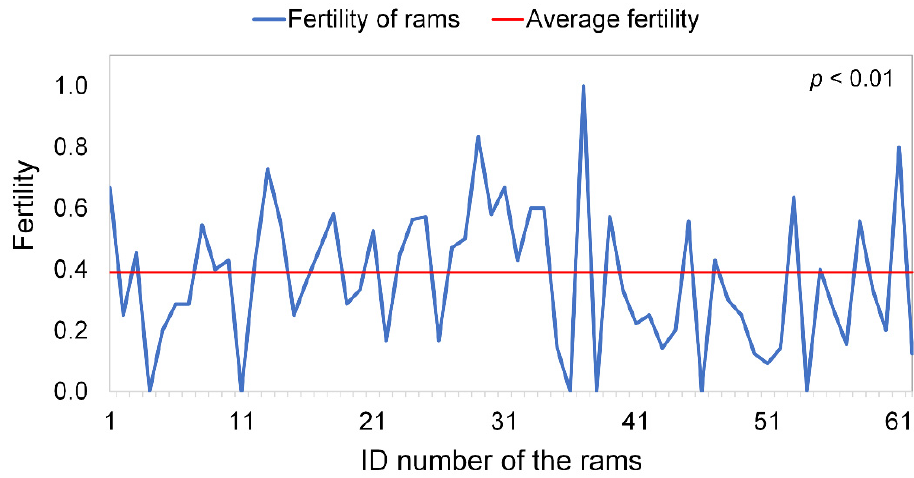
Figure 2. Fertility produced from the semen from each of 62 Churra rams in Spain.